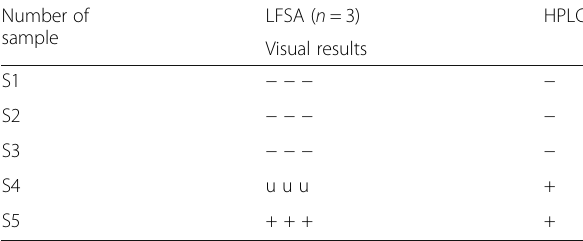
Table 1 Rongalite detected in real samples by aptamer-based lateral flow strip and